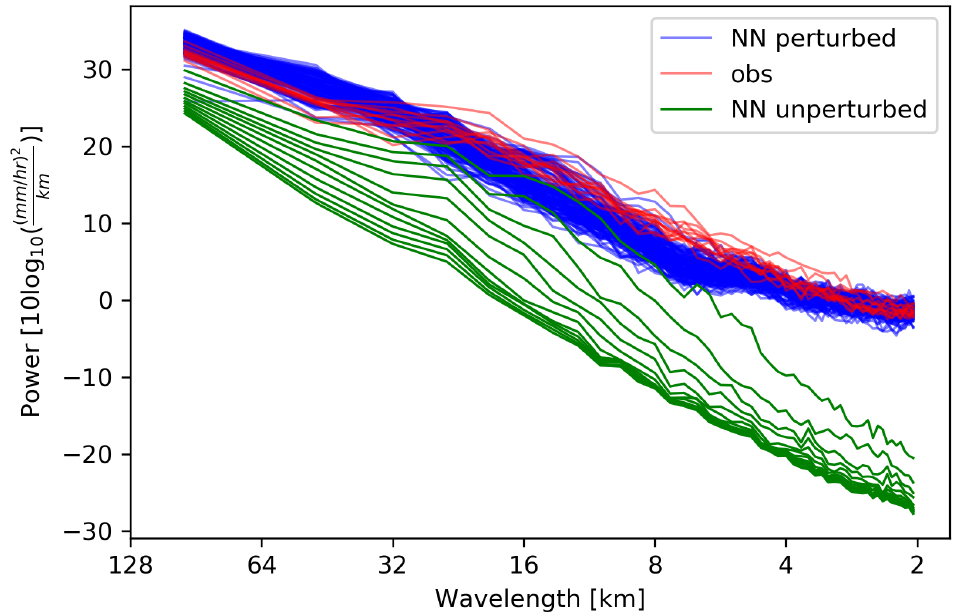
Figure 5. In red, the power spectrum of the 12 images at 5’ intervals of the precipitation field during the nowcast hour; in green, the power spectrum related to the nowcast of the unperturbed PredNet; in blue, the power spectrum for the nowcast of 10 perturbed members.